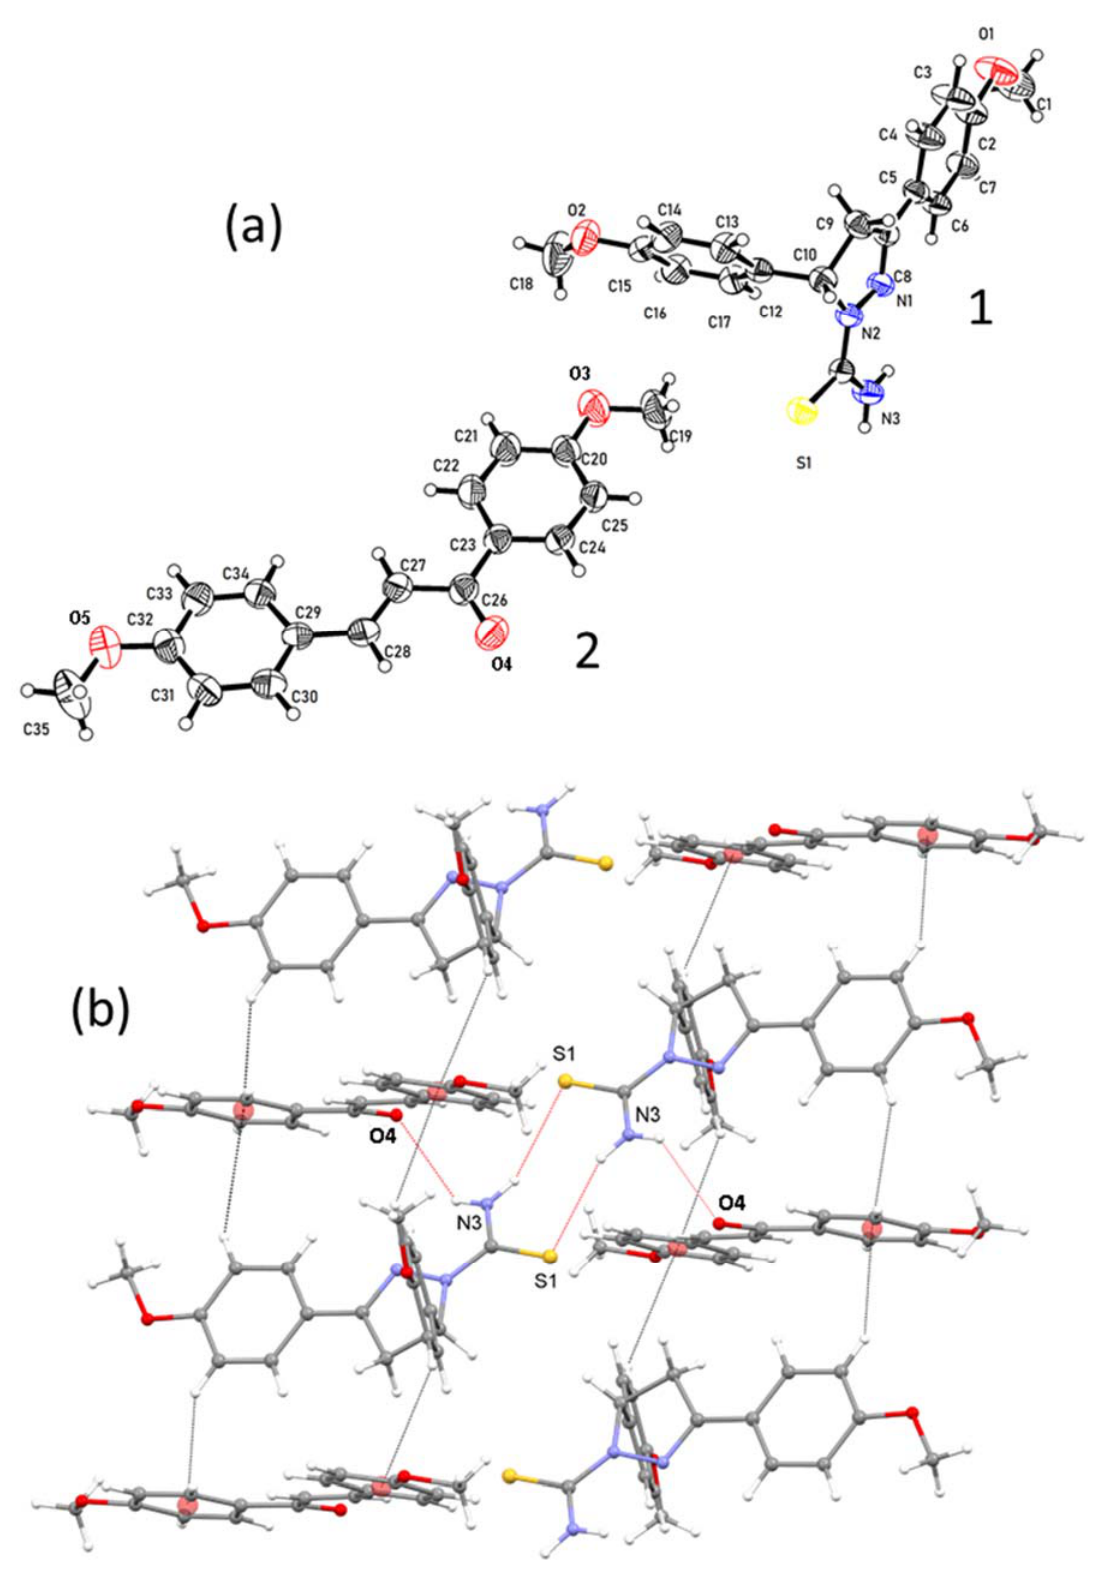
Figure 2. ( a ): The molecules of 1 and 2 in cocrystal 1 – 2 showing anisotropic displacement ellipsoids drawn at 50% probability level and ( b ): a segment of the structure of 1 – 2 showing intermolecular contacts.